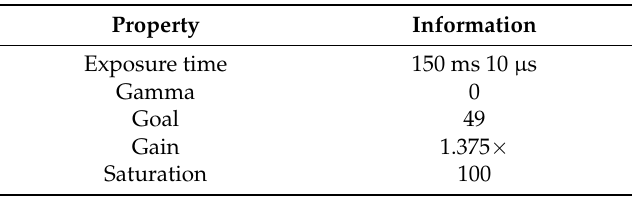
Table 2. Capture Table 2. Capture parameters.